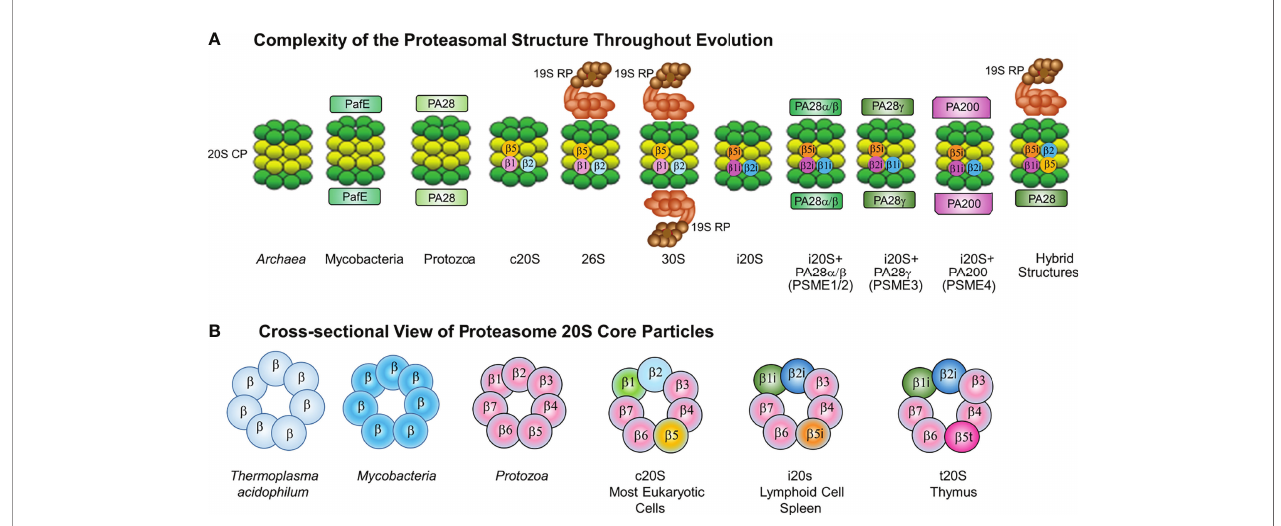
FIGURE 1 | (A) Complexity of the Proteasome Structure Throughout Evolution. The constitutive 20S proteasome is assembled in a (green) and b (yellow) heptameric rings. Constitutive 20S proteasomes (c20S) contain the catalytic subunits b1, b2 and b5. The 20S immunoproteasome (i20S) catalytic core contains three inducible b subunits named b1i, b2i and b5i. immunoproteasomes As previously described, intracellular proteasomes can exist in multiple different forms (Gomes, 2013). Both c20S and i20S proteasomes are found with or without regulators. The c20S is capped at one or both ends by a 19S RP (light brown) to form 26S or 30S proteasomes. The i20S proteasome is capped by either the PA28ab or PA28g complex at either one or both ends. Hybrid proteasome complexes are also found when the catalytic core is simultaneously associated with 19S RP and another type of regulator, e.g., PA28ab, PA28g, PA200. In the cytoplasm ECM29 and PSMF1 can modify the assembly or activity of the proteasome; while in the nucleus PA200 can regulate proteasome activity. (B) Cross-sectional View of Proteasome 20S Core Particles. Shown is a cross-sectional side view of 20S proteasomes showing the evolutionarily conserved barrel-like (a7b7b7a7) structure in eubacterial and eukaryotic proteasomes. Archaea and Mtb proteasomes are depicted as having seven identical b subunits, whereas eukaryotic proteasomes have seven different b subunits. In lymphoid cells and spleen, constitutive 20S proteasome catalytic subunits b1, b2 and b5 are substituted by three inducible b subunits named b1i, b2i and b5i to generate 20S proteasomes. 26S proteasomes exist with either one or two 19S caps, immunoproteasomes containing one or two 11S caps, proteasomes containing the 20S proteasome with one or two PA200 caps (in the nucleus only), and hybrid proteasomes which contain different combinations of 20S and